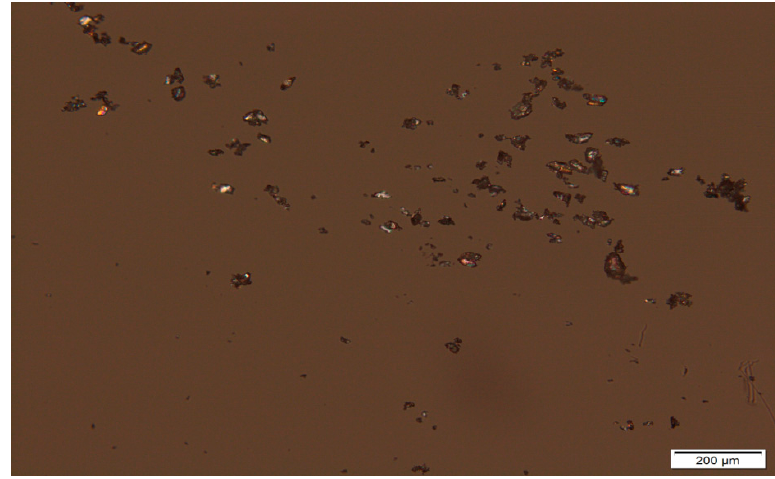
Figure 4. Micrograph of ATH powder sample at 10× magnification.